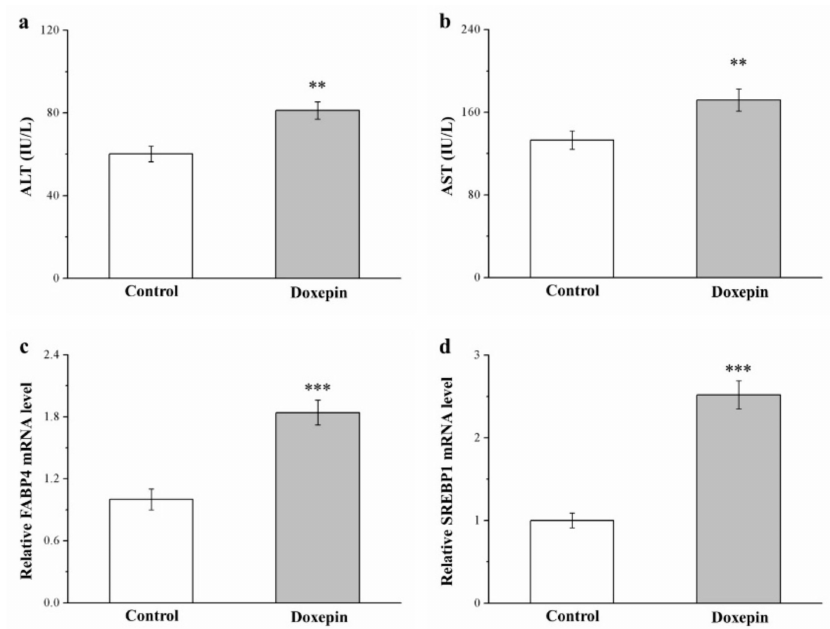
Figure 4. Serum ( a ) ALT and ( b ) AST levels as well as liver ( c ) FABP4 and ( d ) SREBP1 mRNA levels in the control and doxepin treatment groups over 56 treatment days. All values represent means ± standard deviations ( n = 10 for all groups). ** p < 0.01 and *** p < 0.001 indicate high and very high statistical significance,